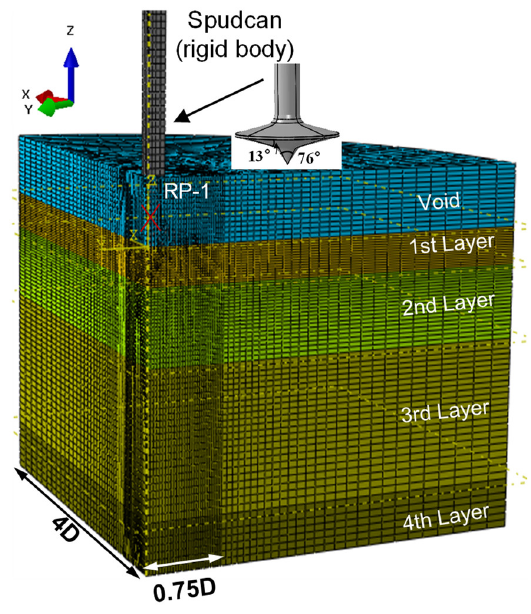
Figure 1. FE model of soil and spudcan.